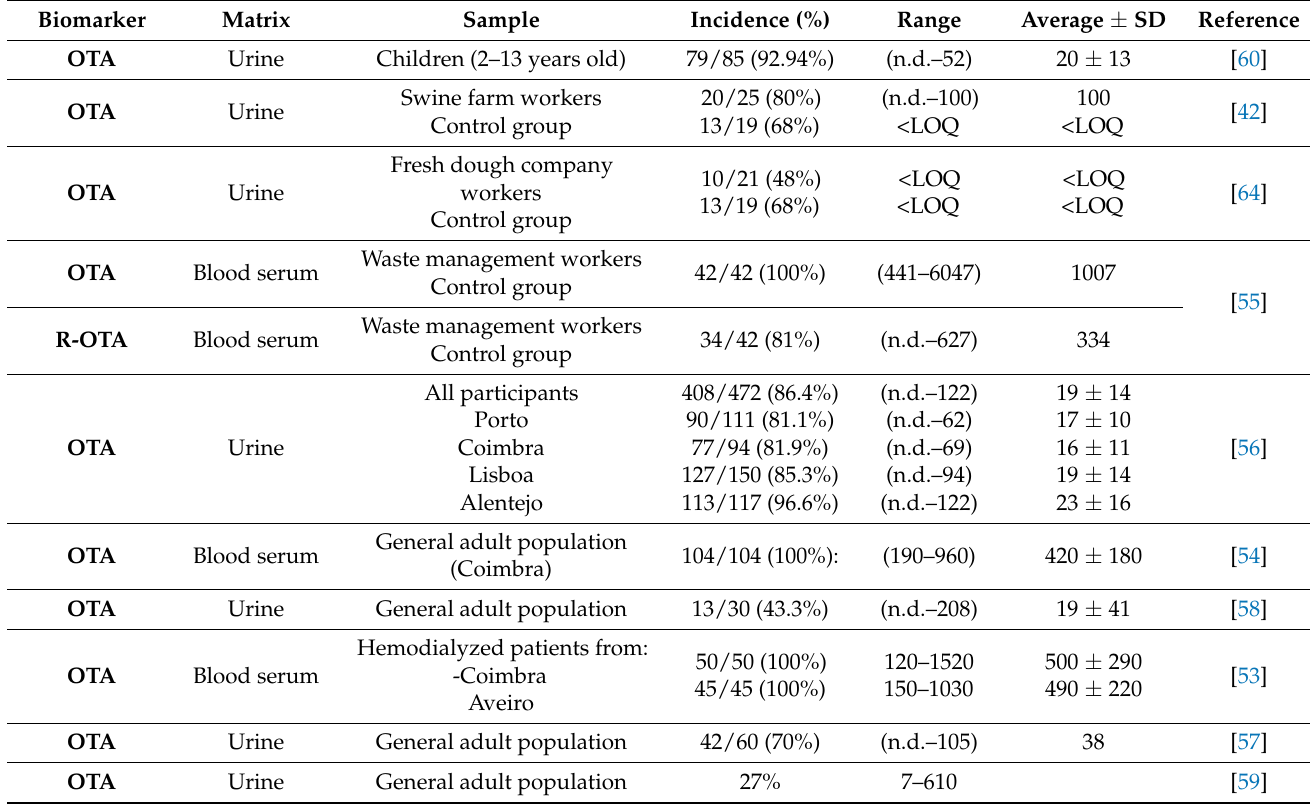
Table 2. The occurrence and levels of OTA (ng L − 1 ) in different biological samples collected among the Portuguese